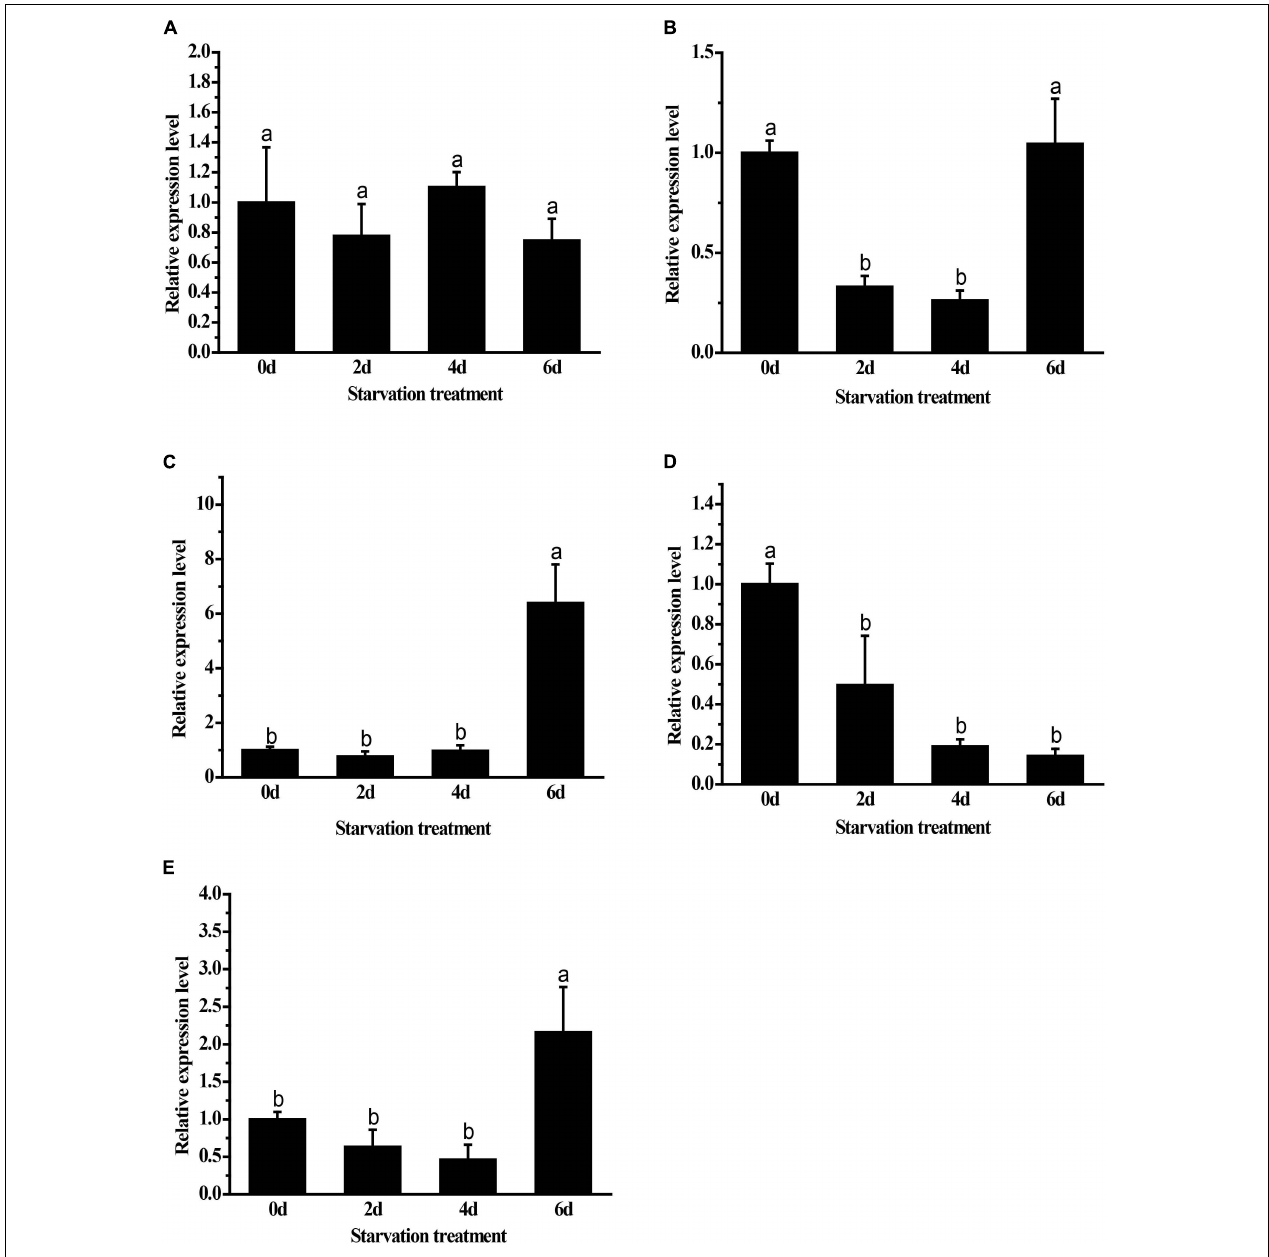
FIGURE 7 | Expression levels of GpHsps after starvation stress. (A) GpHsp71.3 ; (B) GpHsp74.9 ; (C) GpHsp82.4 ; (D) GpHsp89 ; (E) GpHsp93.4 . Data are shown as the mean ± SE of three biological replicates. Differences among triple repeats were analyzed using one-way analysis of variance (Systat, Inc., Evanston, IL) with Tukey’s post hoc test. Different lowercase letters indicate significant differences ( p <